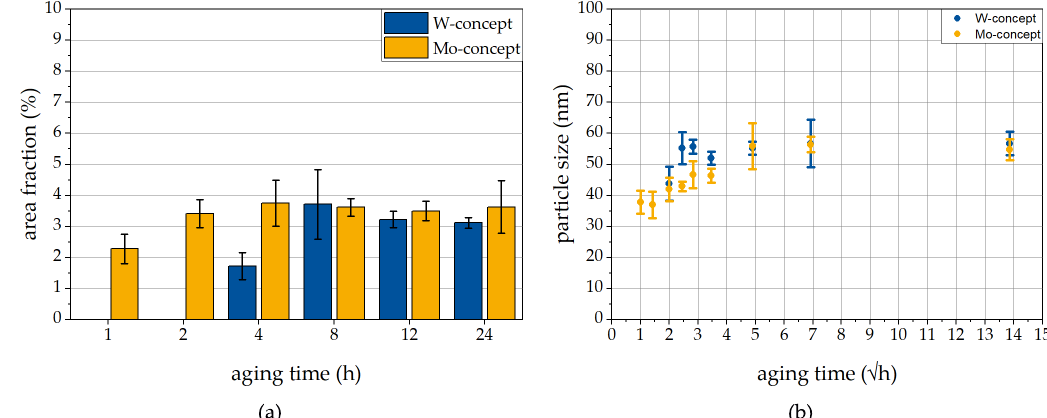
Figure 7. Area fraction of Laves phase in dependency of aging time ( a ) and particle size as function of the square root aging time ( b ) both aged at 650°C for W- and